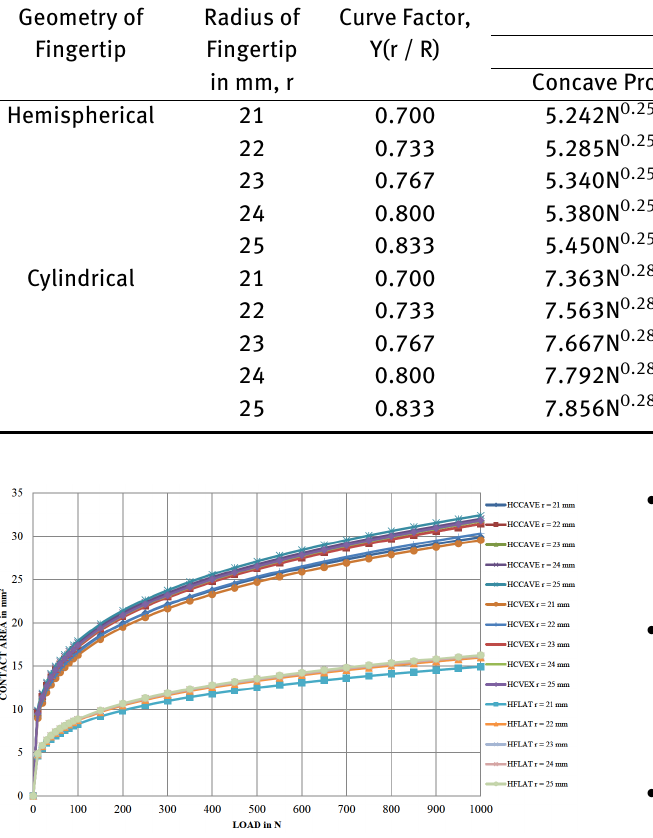
Figure 5: Comparison of area of contact versus applied normal force for hemispherical fingertips